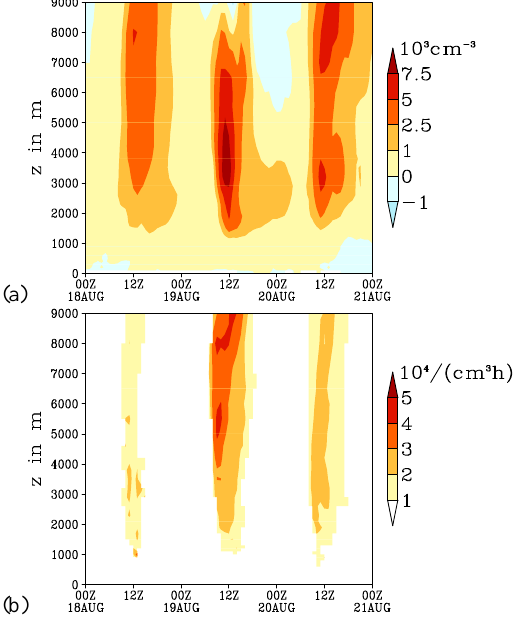
Fig. 6. (a) Time evolution of the profile of the difference in the horizontally averaged total aerosol number concentration of cloudy to cloud free grid points, (b) time evolution of the profile of the horizontally averaged nucleation rate.